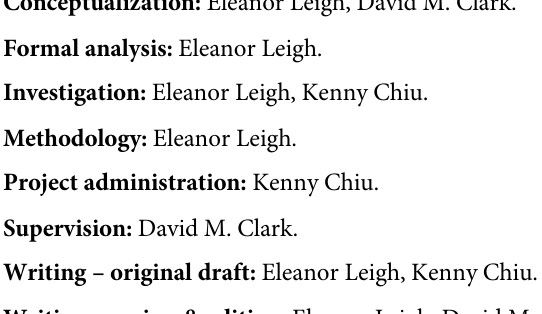
S1 Table. Results of independent sample t-tests between females’ and males’ scores. S2 Table. Results of independent sample t-tests between school 1 and school 2 scores. S3 Table. Measures of different constructs in the